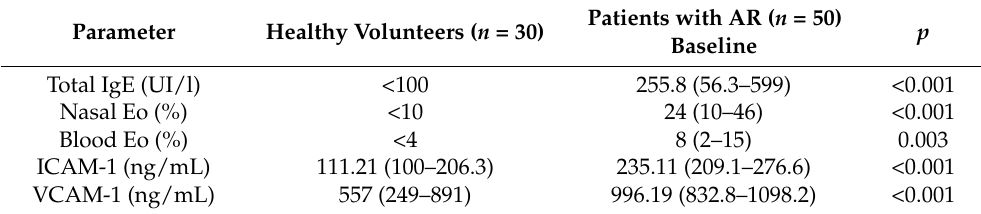
Table 2. Nasal and blood eosinophils, plasmatic values of total IgE and adhesion molecules in healthy volunteers and patients with AR.